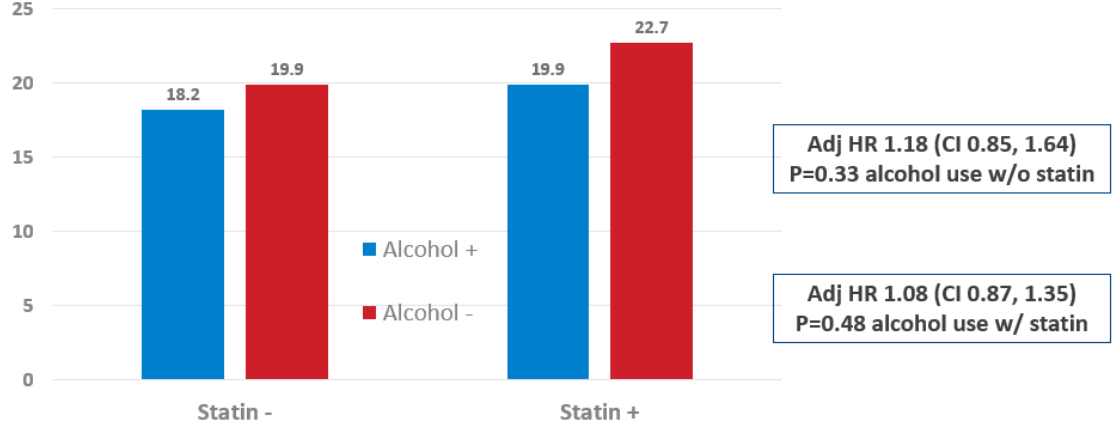
Figure 1. MACE Outcomes in Primary Prevention Patients by Alcohol and Statin Status. Alcohol+ = alcohol user. Alcohol − = Alcohol non-user.